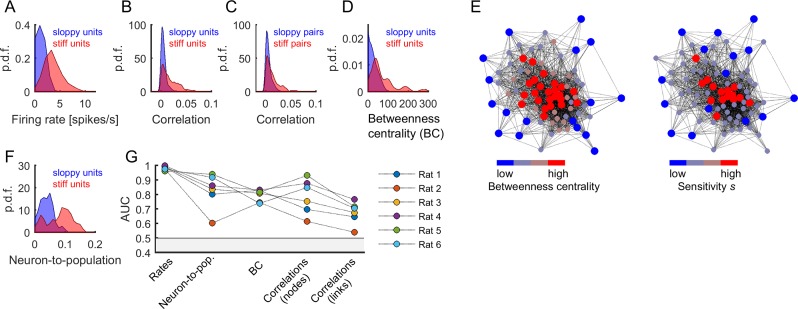
Central and highly active neurons were associated to stiff parameters.(A) Distribution of firing rates of sloppy and stiff neurons. (B) Distribution of correlations among sloppy neurons and among stiff neurons. (C) The distribution of correlations was also calculated for the links (i.e, pairs of neurons with associated parameters Jij). Note that, in principle, links can be related to pairs composed of one sloppy and one stiff neuron. (D) Distribution of betweenness centrality of sloppy and stiff neurons. (E) Connectivity graph: each node represents a neuron and links represent significant correlations between pairs of neurons. The graph was plotted using force-directed layout, that is using attractive forces between strongly connected nodes and repulsive forces between weakly connected nodes. Left: the nodes were colored as a function of betweenness centrality. Right: the nodes were colored as a function of associated sensitivity s. Note the high overlap between both color labeling methods, indicating that sensitivity was highly predictive of the centrality of the nodes. (F) Distribution of neuron-to-population couplings of sloppy and stiff units. Panels A–F show data from rat 1. (G) Area under the receiver operating curve (AUC) quantifying the separation of distributions of sloppy and stiff classes. All AUC values were significantly higher than 0.5 (p < 0.001).